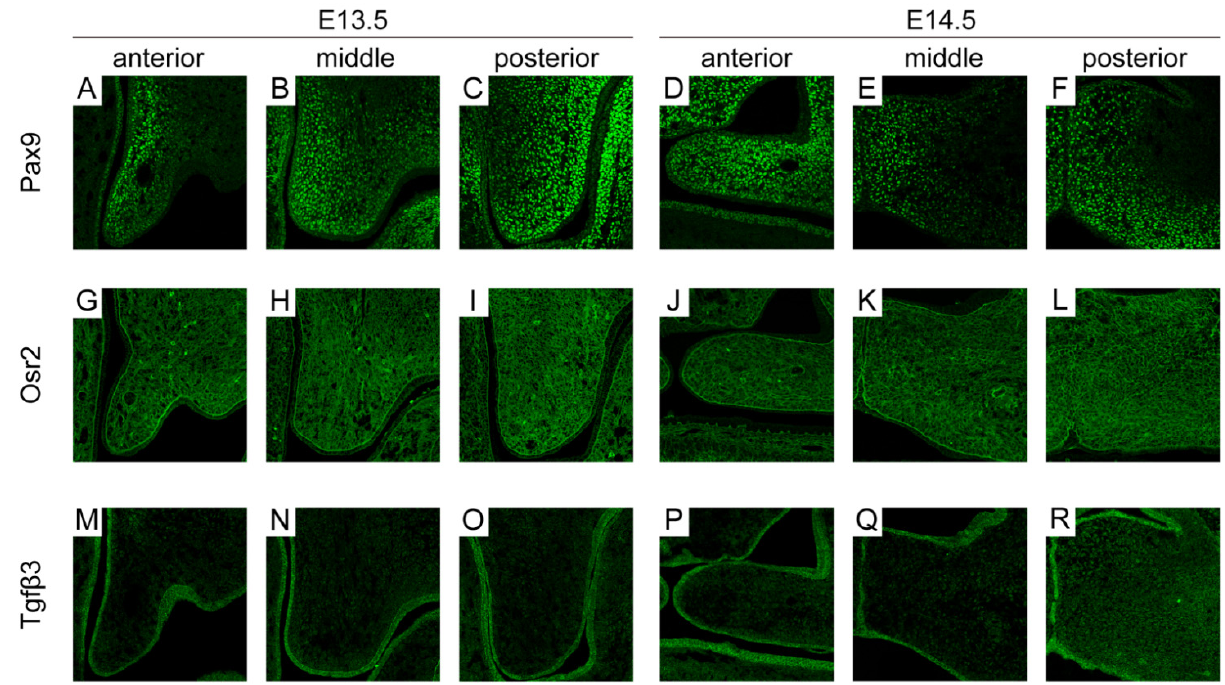
Figure 1. Hematoxylin- and eosin-stained coronal sections of the developing palatal shelves. Histo- logical changes before (E13.5) and after (E14.5) palatal elevation. Coronal planes along the anterior– posterior axis in embryos: anterior (anterior to molar tooth bud), middle (same plane as molar tooth bud), and posterior (posterior to molar tooth bud). The boxed areas show the corresponding areas at higher magnification in Figures 2 and 3. Scale bar: 500 μ m.